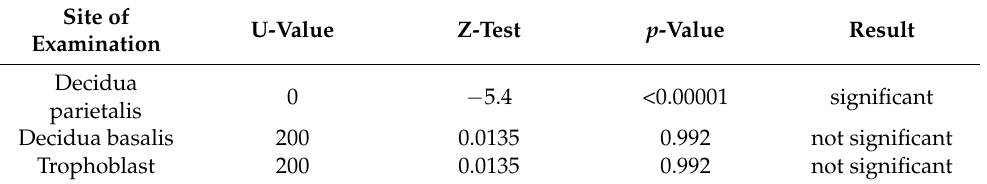
Table 8. CD20 + comparison among the experimental (RPL) and control (electively abortion) group. Site